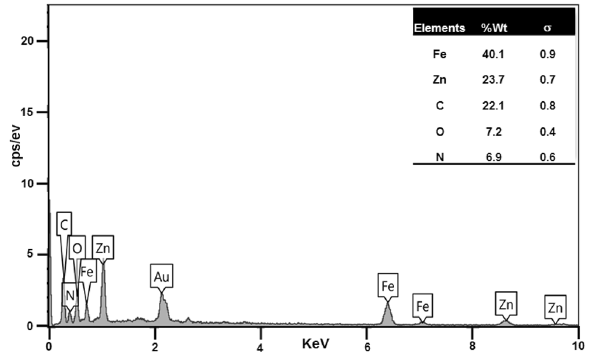
Figure 1. EDX spectrum of Fe 3 O 4 @ZIF-8